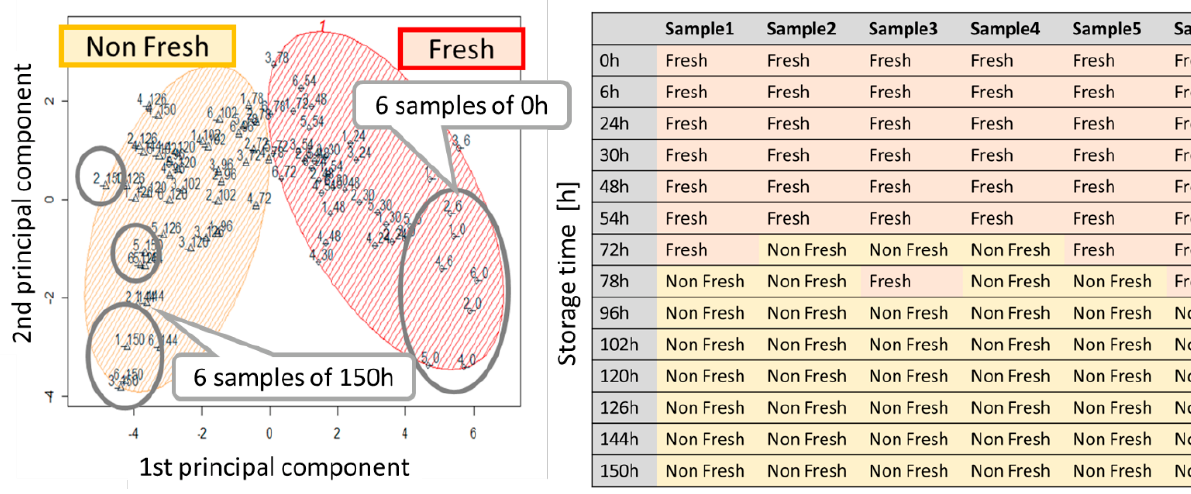
Fig. 16: Classification results by K-means